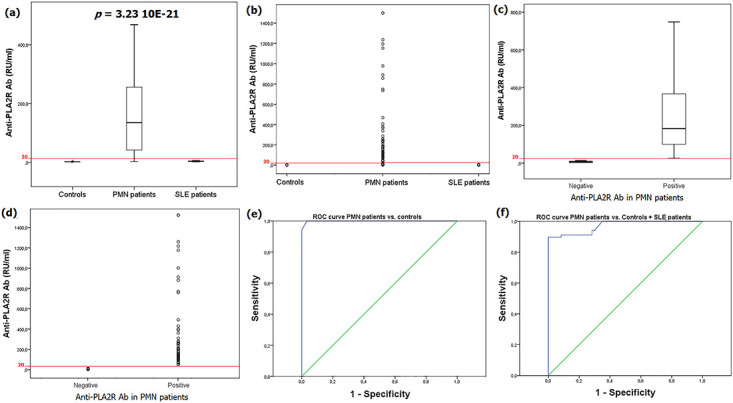
Comparative analysis of Anti-PLA2R Ab in PMN, SLE and controls.(a) Box plot underlining significant higher anti-PLA2R Ab levels in PMN patients. (b) Dot plot highlighting the anti-PLA2R antibody level in PMN, SLE and controls. (c) Box plot showing anti-PLA2R antibody level in positive and negative PMN patients. (d) Dot plot highlighting the anti-PLA2R antibody level in positive and negative PMN for anti-PLA2R Ab. (e) ROC curve for anti-PLA2R Ab (PMN vs. Controls): AUC = 99.19% [0.996–1] p<0.0001; Cut-off = 2.6 RU/ml, specificity = 100%, sensitivity = 94.1%. (f) ROC curve for anti-PLA2R Ab (PMN vs. SLE + Controls): AUC = 97.1% [0.947–0.995], p<0.0001; cut-off = 7.55 RU/ml, specificity = 100%, sensitivity = 89.7%.